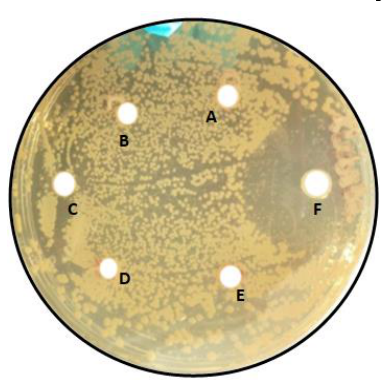
Determination of Antimicrobial activity of Crude venom by Agar-disc diffusion method; A: Crude Venom, B: Deionized Water, C: Colistin, D: Polymyxin